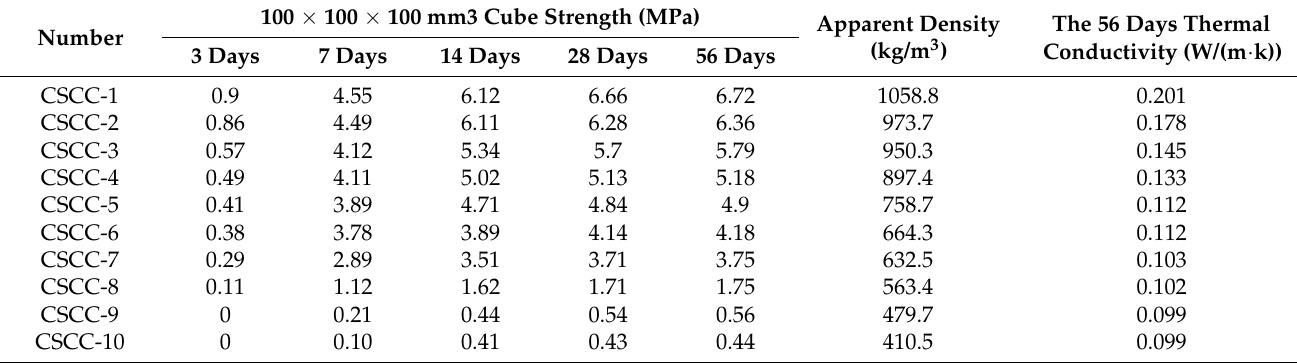
Table 6. Compressive strength and thermal conductivity of